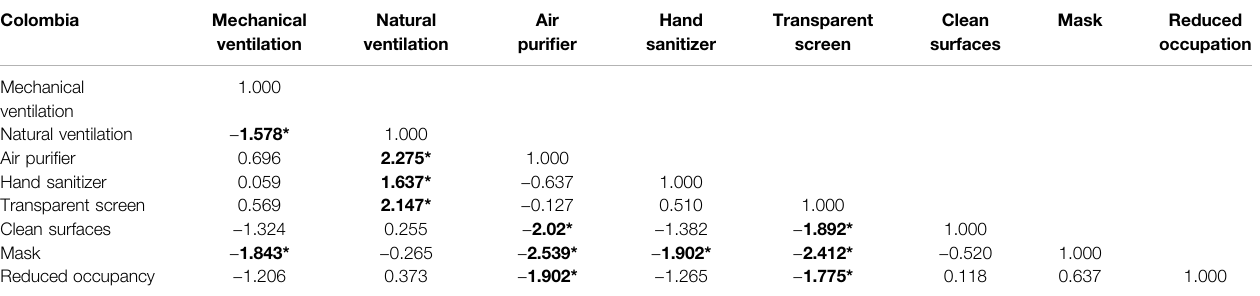
* Indicates signi fi cant results at p < 0.05